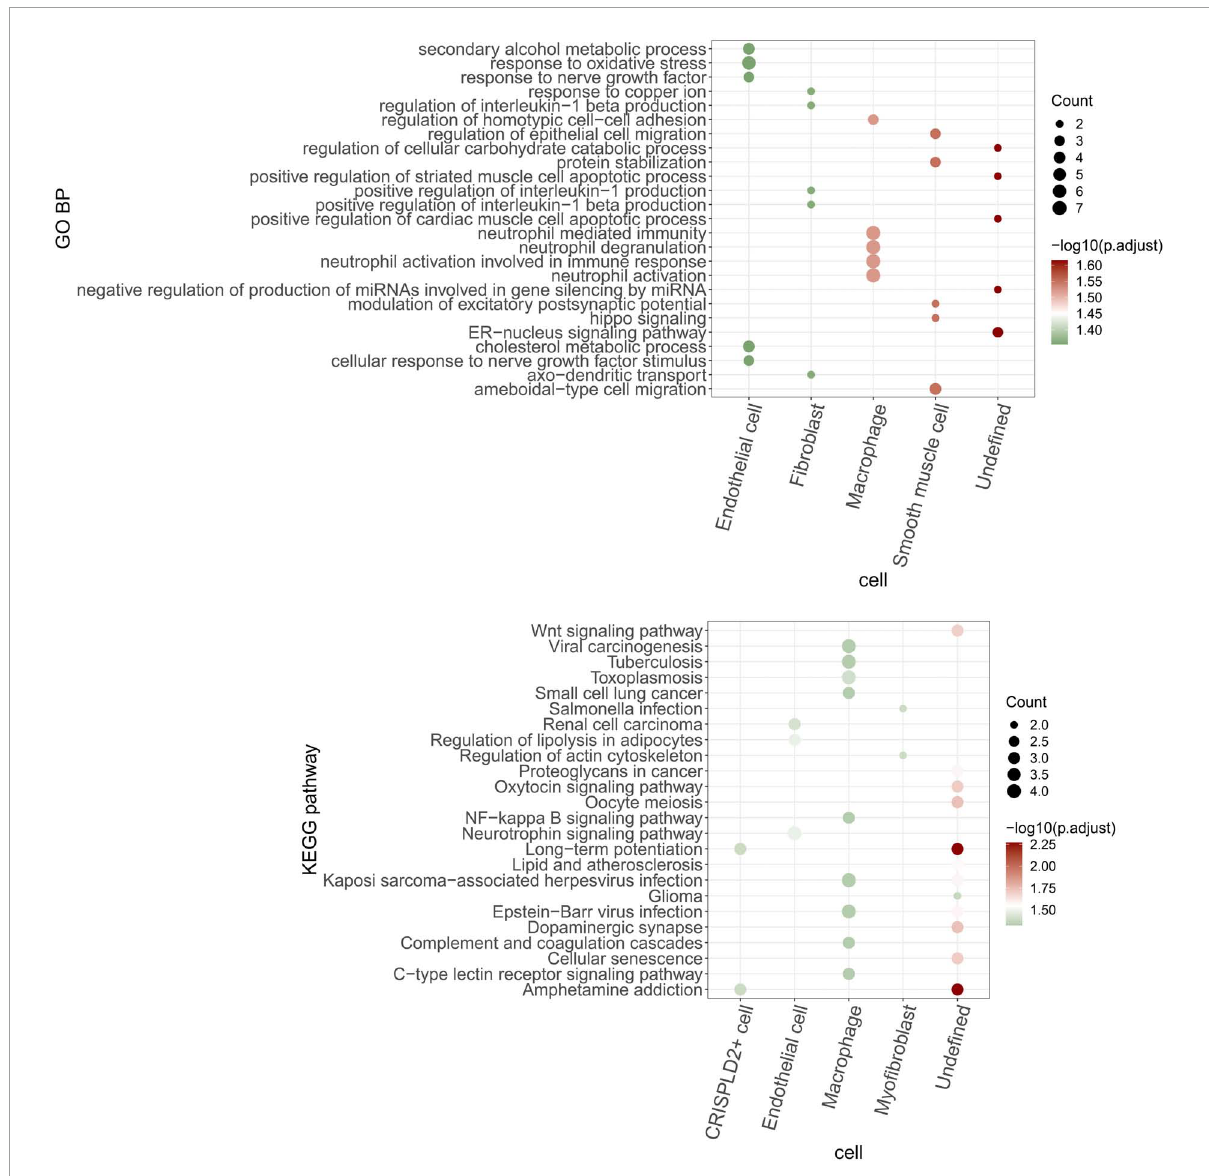
FIGURE9 GO BP and KEGG pathways are enriched by mRNAs in the circRNA–miRNA–mRNA regulatory network of each cell type. The bubble size indicates the number of enriched genes. The color shows the enrichment significance and red is the most significant.